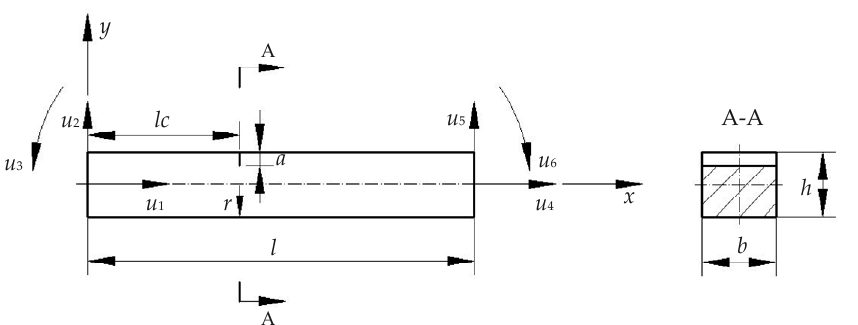
Figure 4. Model of beam element with a breathing crack.